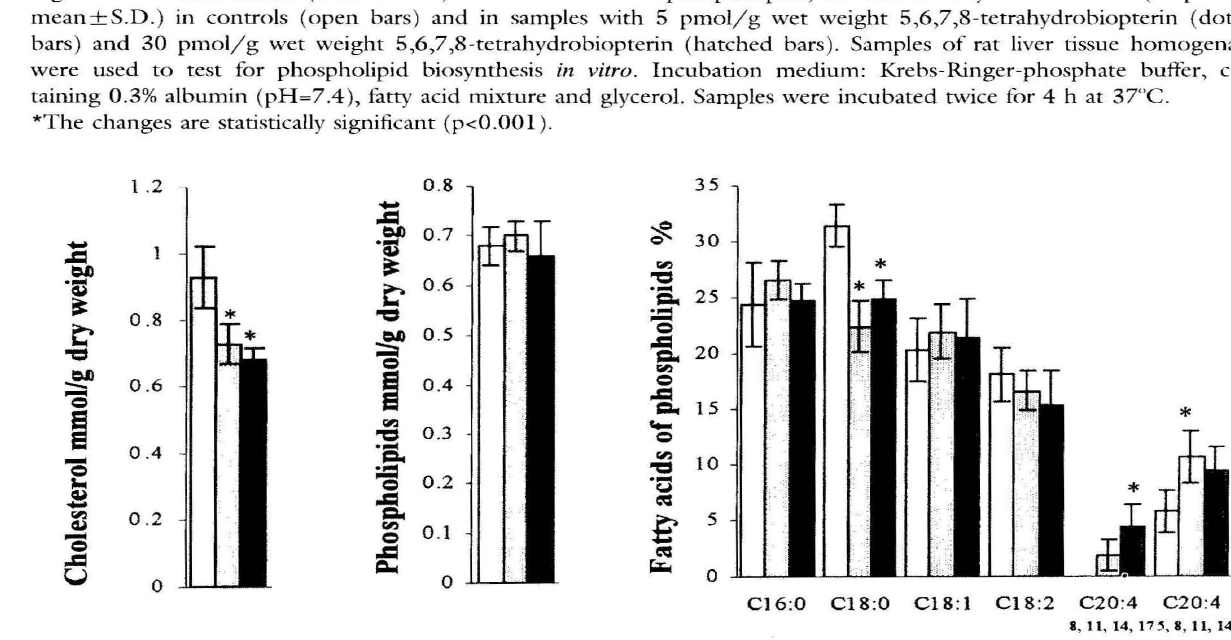
Figure 6. Concentrations (mean ± S.D.) of cholesterol and phospholipids, as well as fatty acid content (in percent: mean±S.D.) in controls (open bars) and in samples with 5 pmoljg wet weight biopterin (dotted bars) and 30 pmoljg wet weight biopterin (hatched bars). Samples of rat liver tissue homogenates were used to test for phospholipid biosyn thesis in vitro. Incubation medium: Krebs-Ringer-phosphate buffer, containing 0.3% albumin (pH=7.4 ), fatty acid mix ture and glycerol. Samples were incubated twice fo r 4 h at 37"C. *The changes are statistically significant (p<O.OOl ).